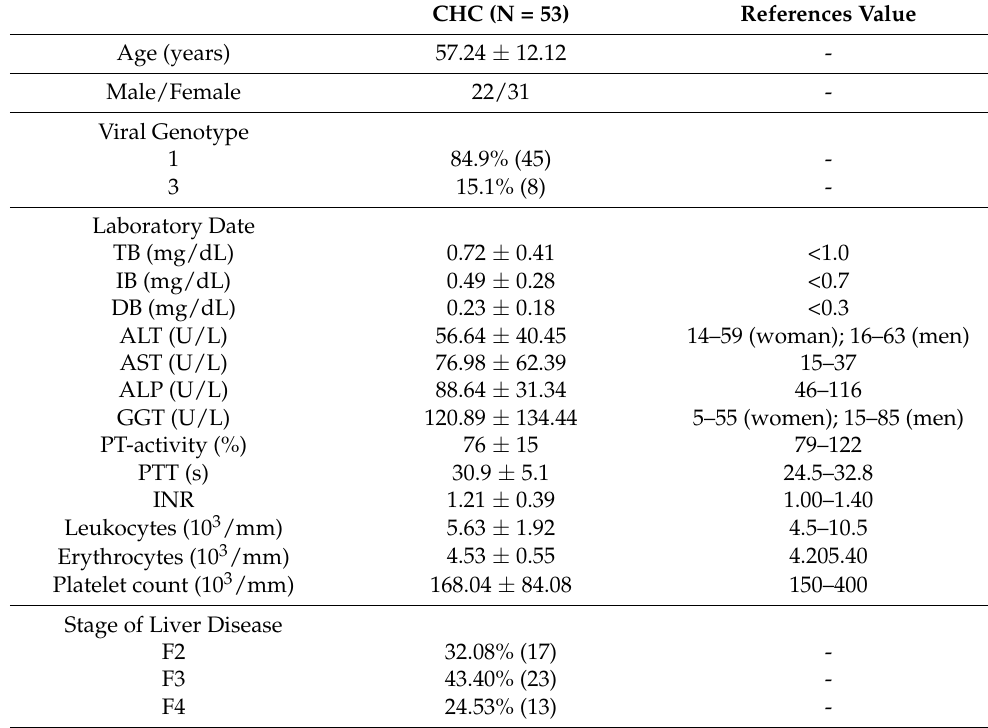
Table 1. Baseline Characteristics of HCV